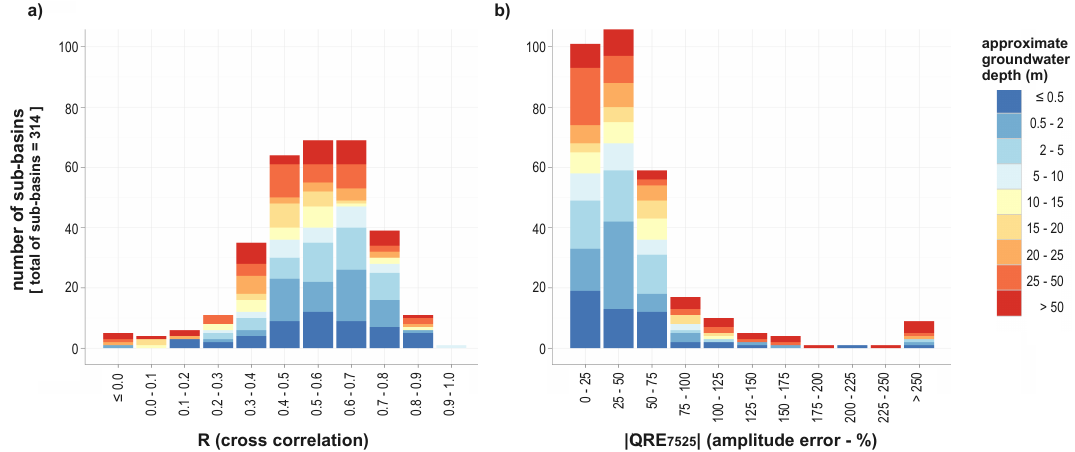
Fig. 12. Histograms of maximum values of all maps in Fig. 9 (cross correlation R cor ) and minimum values of all maps in Fig. 10 (amplitude (cid:12) (cid:12) error (cid:12) QRE 7525 (cid:12) ). Each bar in the histogram is clustered based on approximate groundwater depths that are calculated by averaging the 34-yr 1974–2008 average modeled groundwater heads of all scenarios. Note that, to calculate these average depths, we used only cells with measuring